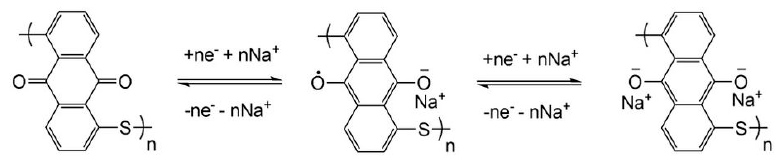
Figure 2. The structure of several polyquinones suitable for NIBs.